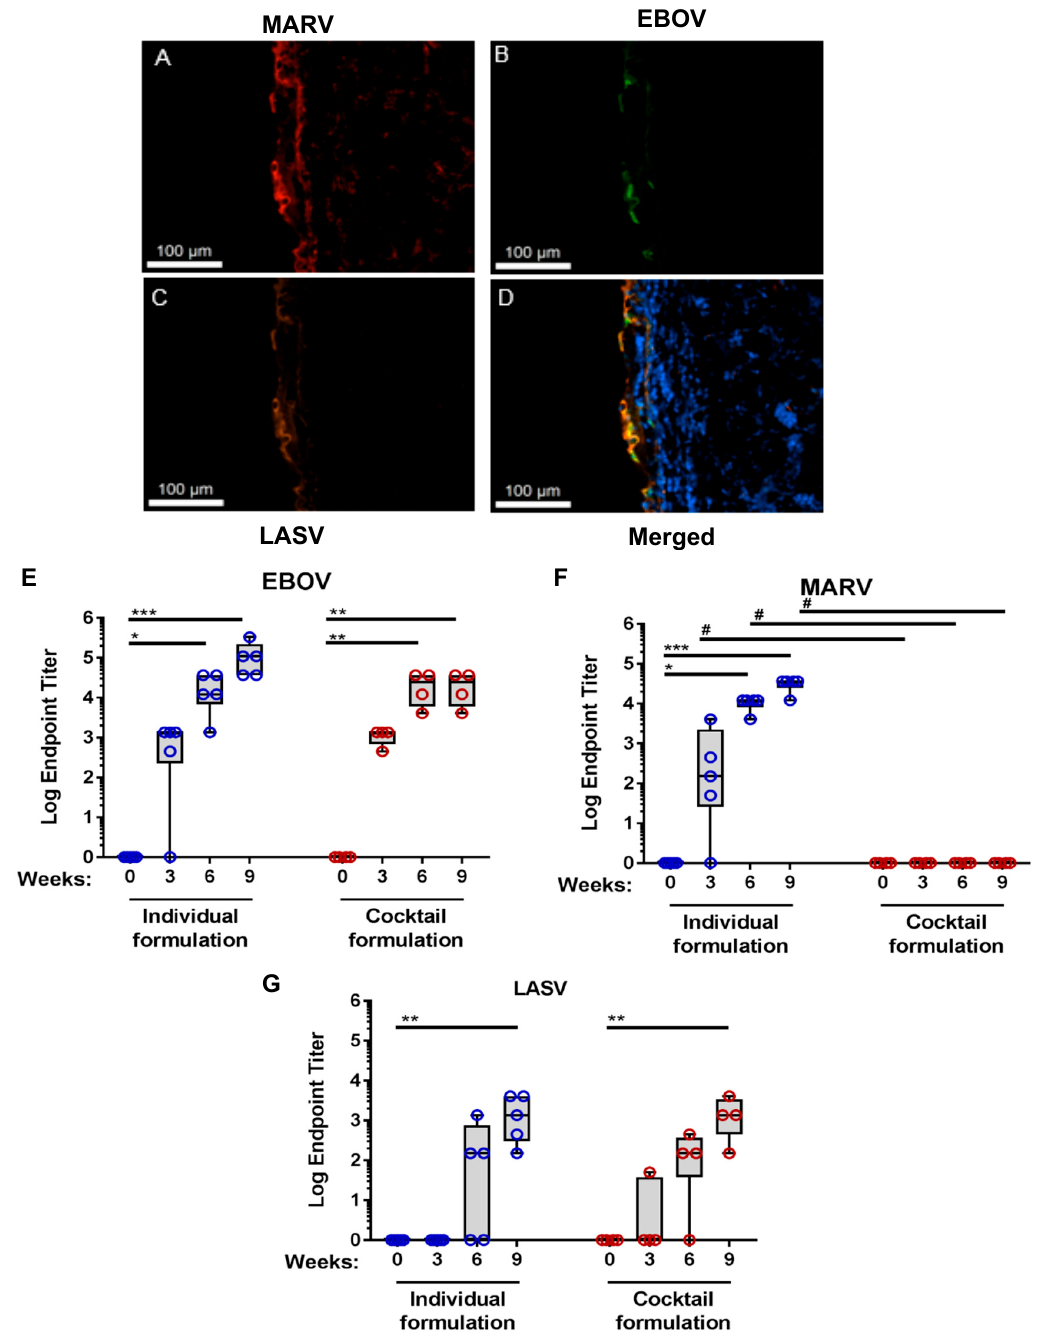
Figure 1. Co-expression of Ebola, Lassa, and Marburg glycoproteins in guinea pig skin and robust humoral response to MHFV DNA vaccine in guinea pigs. ( A – C ) Immunohistochemistry detection of encoded plasmid DNA antigens expressed in skin tissue 24 hours after delivery of co-formulated MHFV vaccine. Expression of plasmid-encoded MARV GP in red ( A ), EBOV GP in green ( B ), and LASV GP in yellow/orange ( C ) were detected by anti-His, Flag, and Myc tag antibodies respectively. Merged image illustrates co-localized signal for the majority of cells suggesting co-expression ( D ). ( E – G ) MHFV humoral response induces humoral response in guinea pigs. Hartley guinea pigs ( n = 5/group) were immunized with a combination of pEBOV, pMARV, and pLASV plasmids as either individual plasmids (individual formulation, blue) or as a co-formulation (cocktail formulation, red) delivered by ID-EP on days 0, 21, and 42. Serum IgG antibody endpoint titers (EPTs) for individual guinea pigs were measured at the indicated timepoints by binding ELISA against EBOV GP ( E ), MARV GP ( F ), and LASV GP ( G ) antigens. The * p < 0.05, ** p < 0.01, *** p < 0.005 as compared with week 0 for the indicated timepoint; # is p < 0.05 comparing individual to cocktail formulation for the indicated timepoint.